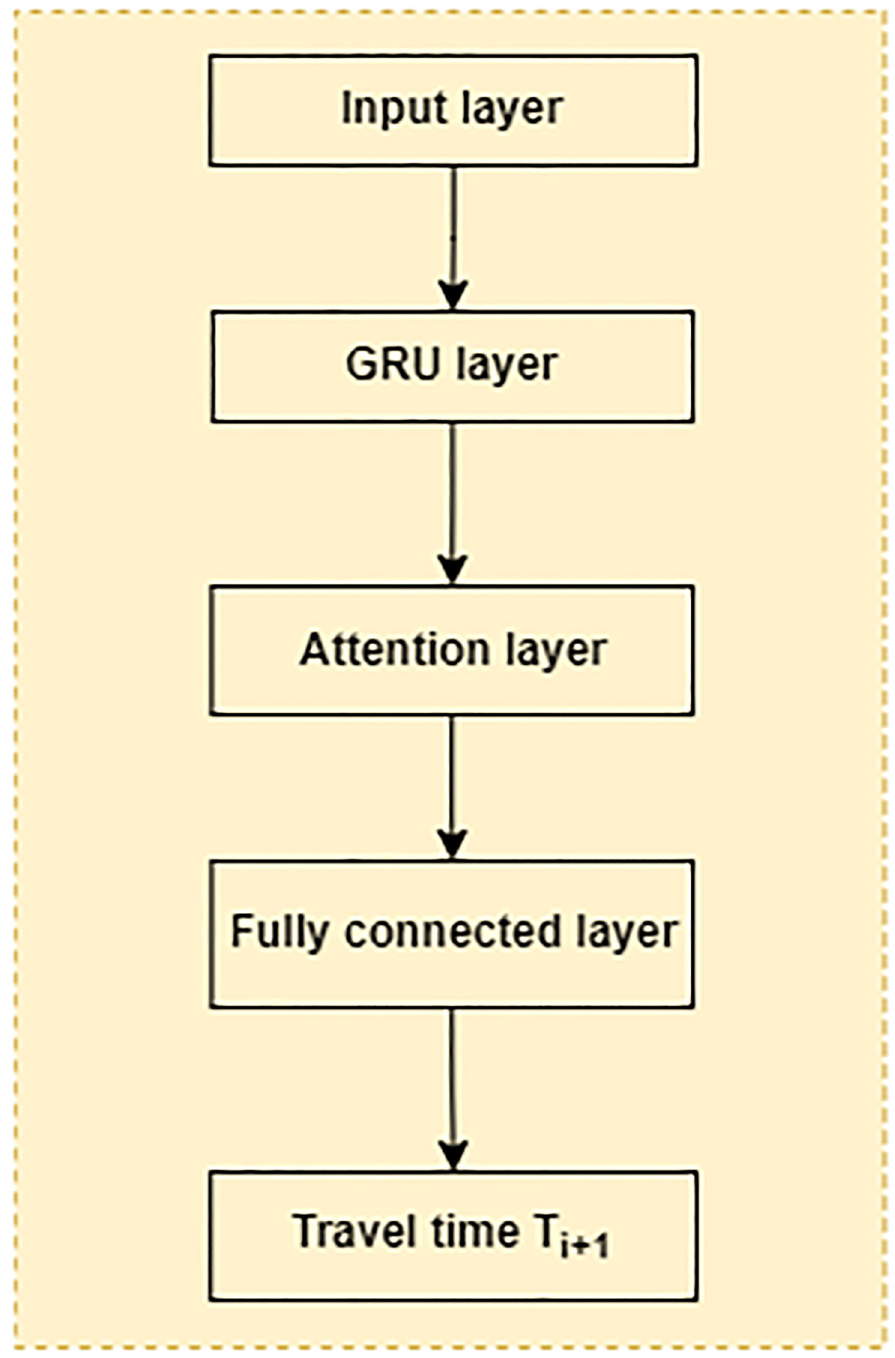
Fig 2. Layers of the proposed GRU